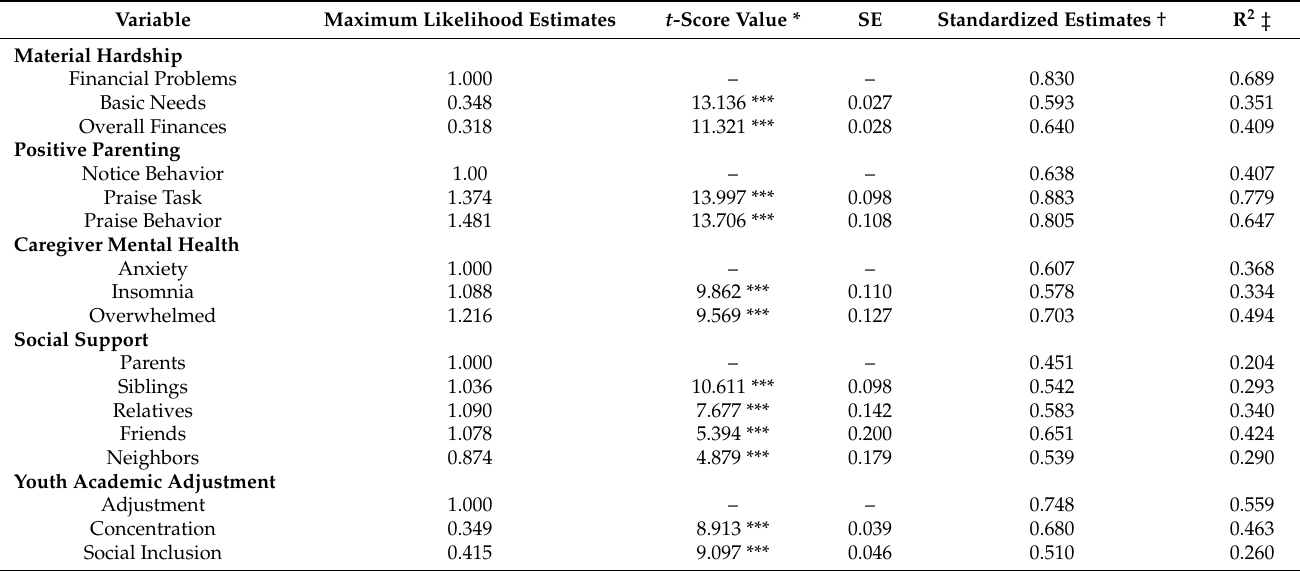
Table 3. Parameter Estimates for the Final Model.